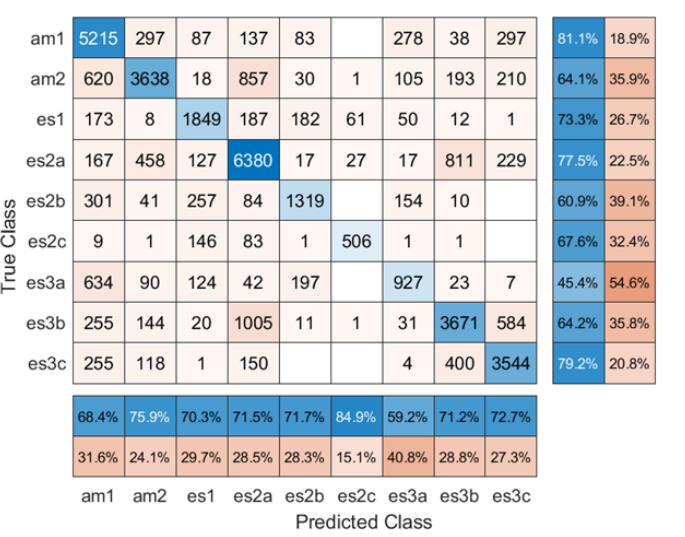
Figure 12. Accuracy matrix of best SEAS RF model (OA: 71.2%).